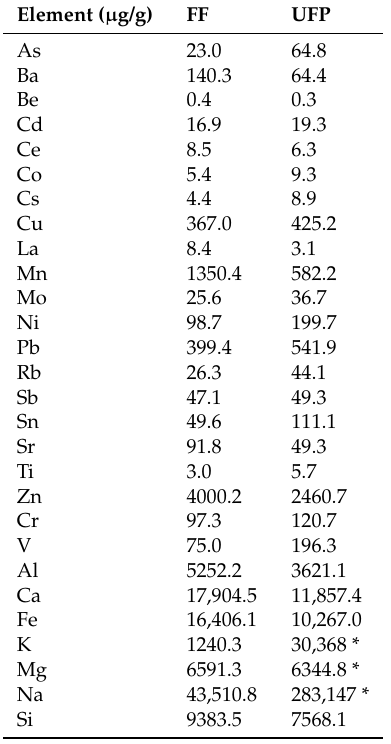
Table 1. Elemental composition of FF and UFP quantified by ICP-MS. Values are the mean of measurements carried out on three sub-samples representative of the initial sample.